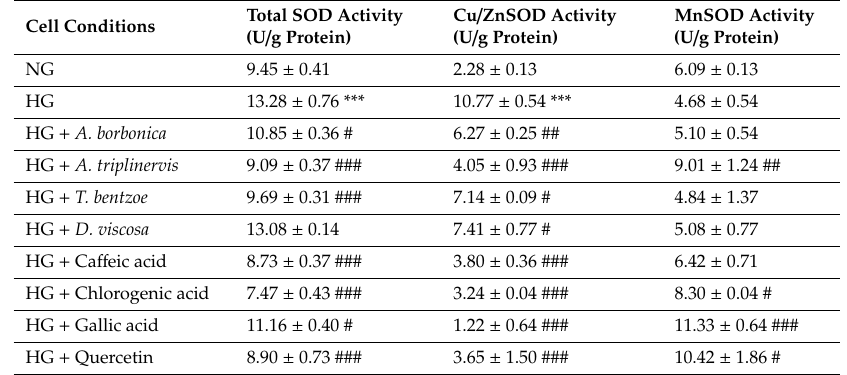
Table 5. E ff ect of polyphenols on superoxide dismutase (SOD) activity on cerebral endothelial cells in Hyperglycemic